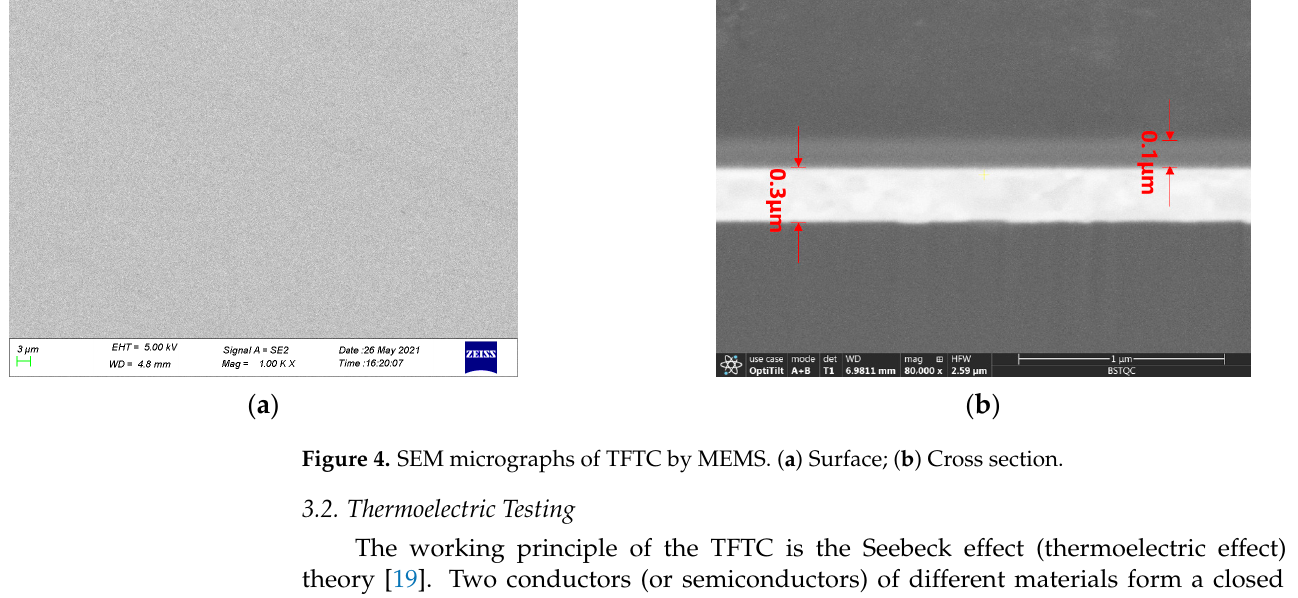
Figure 4. SEM micrographs of TFTC by MEMS. ( a ) Surface; ( b ) Cross section.